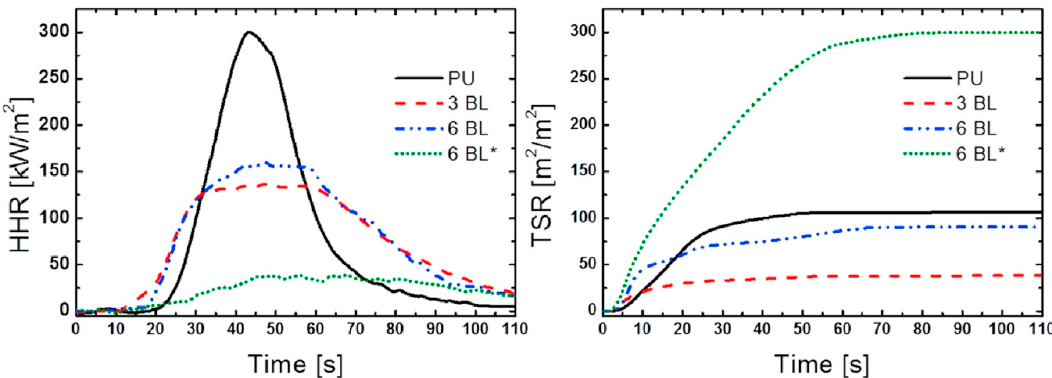
Figure 30. Heat Release Rate ( a ) and Total Smoke Release (TSR) curves of untreated polyurethane foam (PU) and of foams coated with 3 (“3BL”) and 6 (“6BL”) chitosan/graphene oxide bi-layers. 6BL* indicates non-igniting samples. Reprinted with permission from [56]. Copyright 2018, Elsevier.